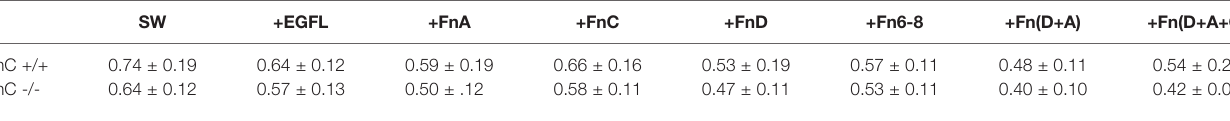
TABLE 2 | Mean value ± standard deviation for relative gap